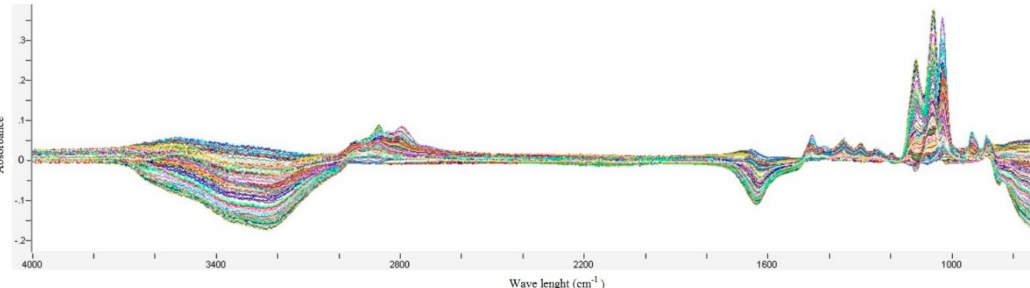
Figure 2. All spectra from the calibration solutions for the MDEA-H 2 O, TEG-H 2 O, MDEA-TEG-H 2 O, and MDEA-TEG-H 2 O-CO 2